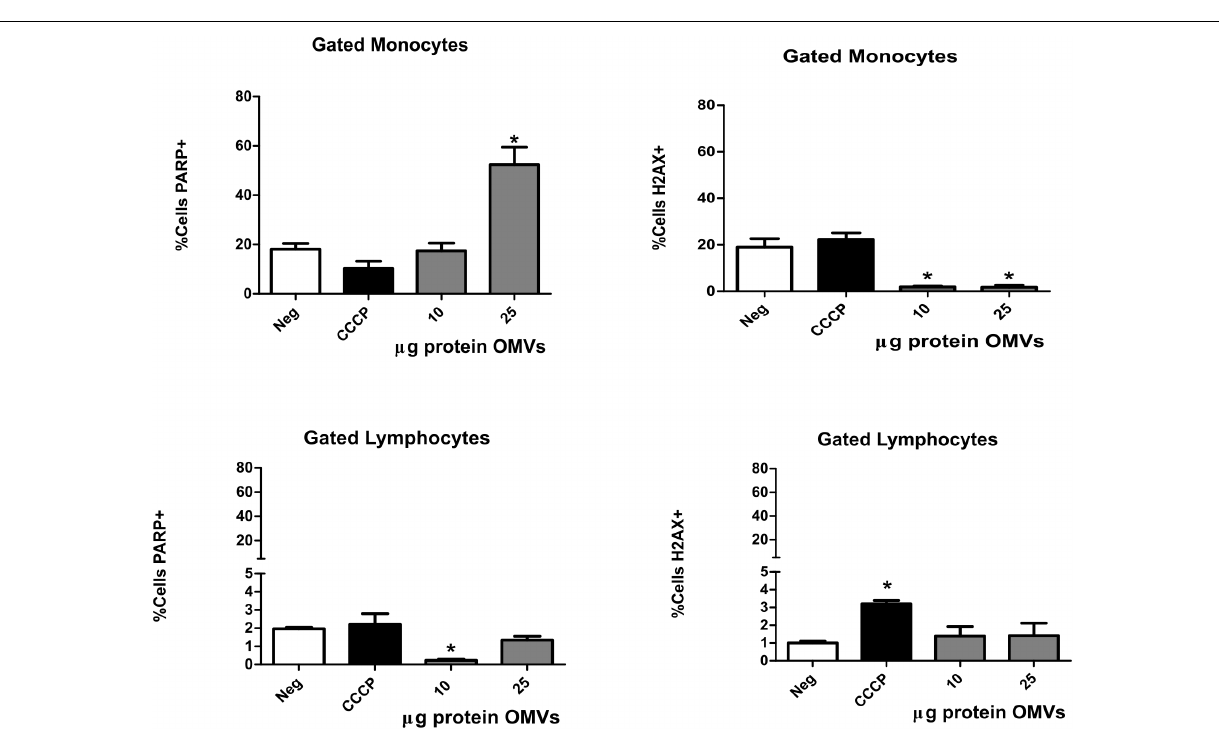
FIGURE 6 | Apoptosis and DNA damage of PBMCs induced by A. hydrophila ATCC R (cid:13) 7966 TM OMVs. PBMCs from healthy donor were co-cultured with different concentrations of A. hydrophila OMVs during 24 h. Apoptosis and DNA damaged was evaluated by flow cytometry with mAbs anti-PARP and anti-H2AX. CCCP was used as control for apoptosis induction. ∗ P <